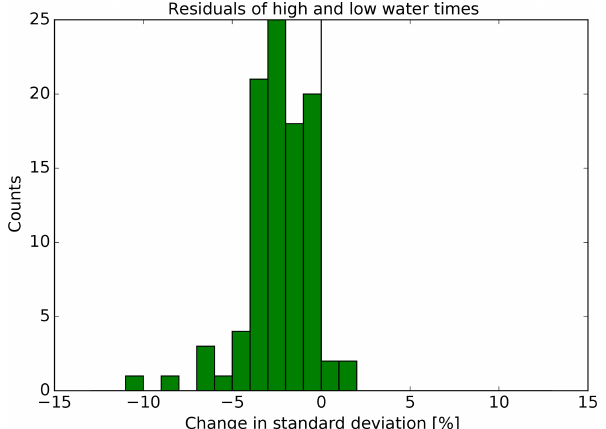
Figure 8. Histogram of the change in the standard deviation of the residuals of high- and low-water times for all 98 tide gauges.